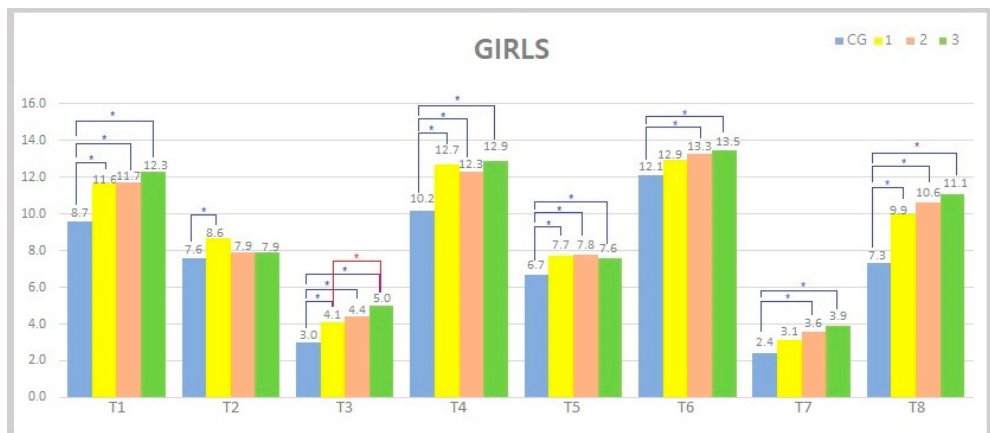
Figure 2. Representation of variables and mean values within individual groups in girls. (CG: control group, 1: experimental group that practiced for 120 h, G2—350 h of exercise, G3—470 h of exercise). (T1—motor precision, T2—motor integration, T3—ambidexterity, T4—hand coordination, T5—balance, T6—bilateral coordination, T7—speed and agility, T8—strength); * represents a statistically significant difference between the groups ( p < 0.05).